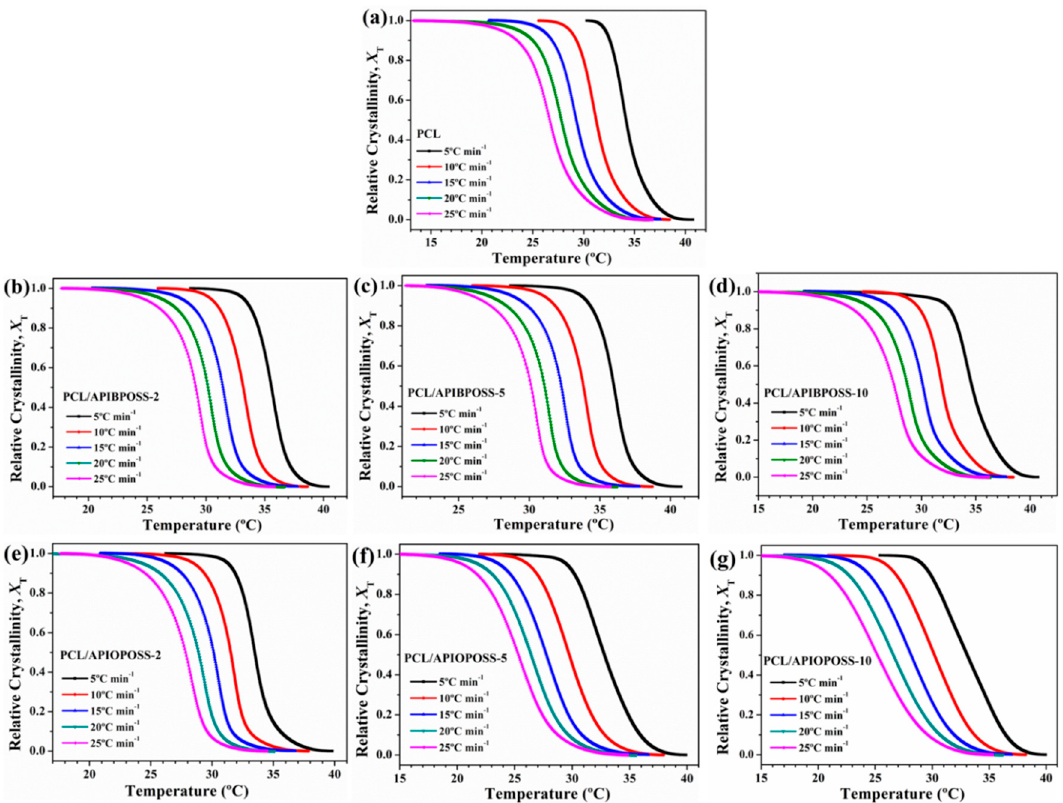
Figure 8. Development of relative crystallinity with temperature for non ‐ isothermal crystallization of: ( a ) PCL, ( b – d ) PCL / APIBPOSS nanocomposites, ( e – g ) PCL / APIOPOSS nanocomposites at various cooling rates.